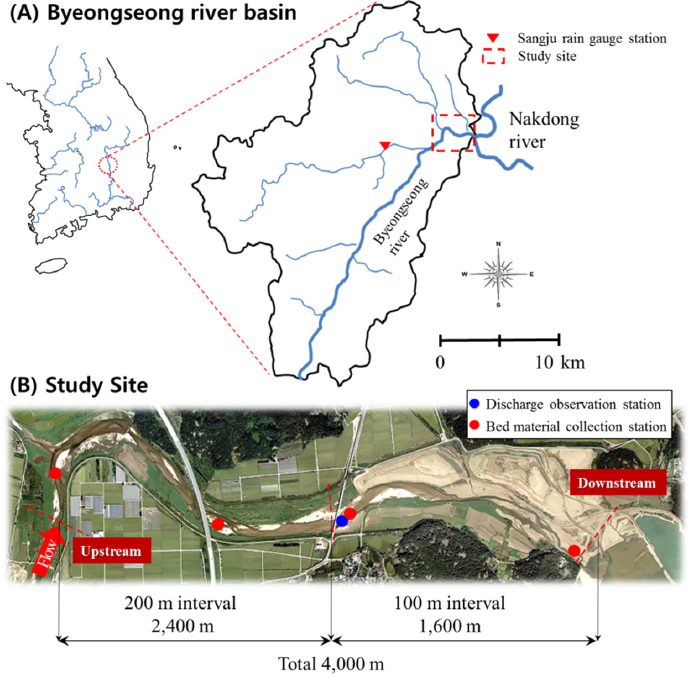
Figure 1. Study area: ( A ) Byeongseong river basin, ( B ) study site of the Byeongseong river and cross-section intervals.